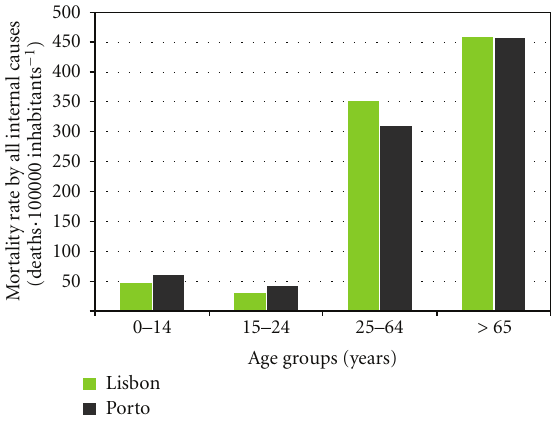
Figure 6: Annual mortality rate by all internal causes in Lisbon and Porto districts by age